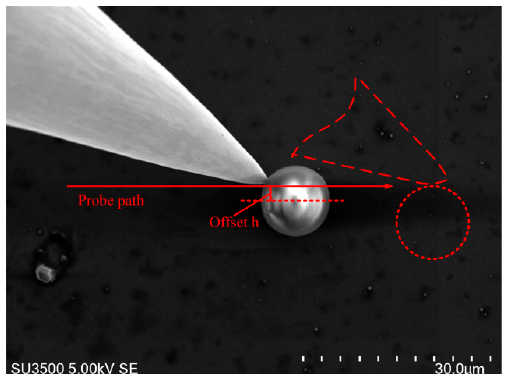
Figure 5. Tip–microparticle interaction. Tip push path and offset, h, are labeled.